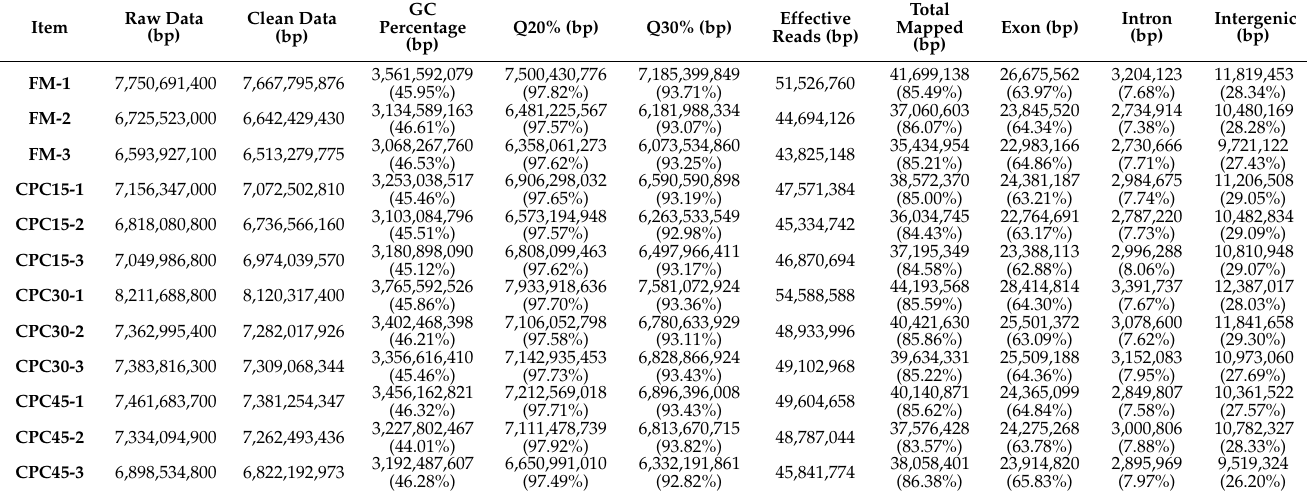
Table 5. Statistics of transcriptome sequencing in L. vannamei